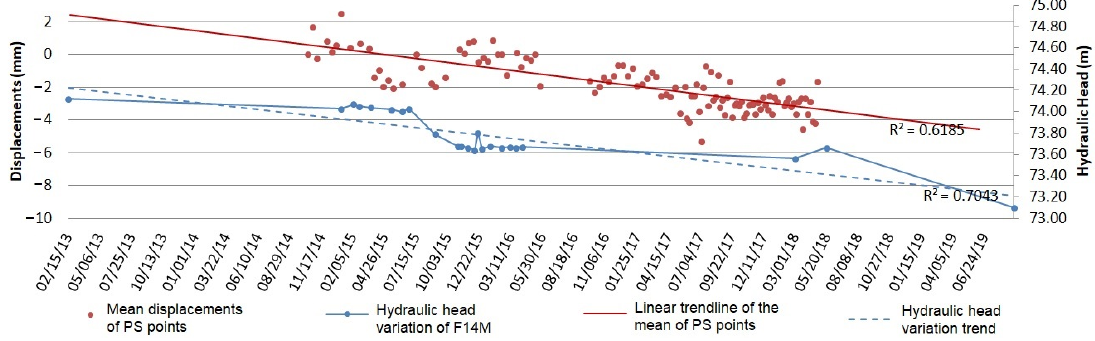
Figure 13. Correlation between displacements of PS points and hydraulic head. Left y -axis indicates displacements, right y -axis indicates hydraulic head variation, and the x -axis indicates the time scale. Red circles represent the variation of the displacements considering the mean of the PS points inside the 100 m buffer. Red line is the linear trend of the displacements of the PS points. Blue line represents the hydraulic head variation for the borehole F14M in the confined middle aquifer. The blue dotted line is the hydraulic head variation trend.